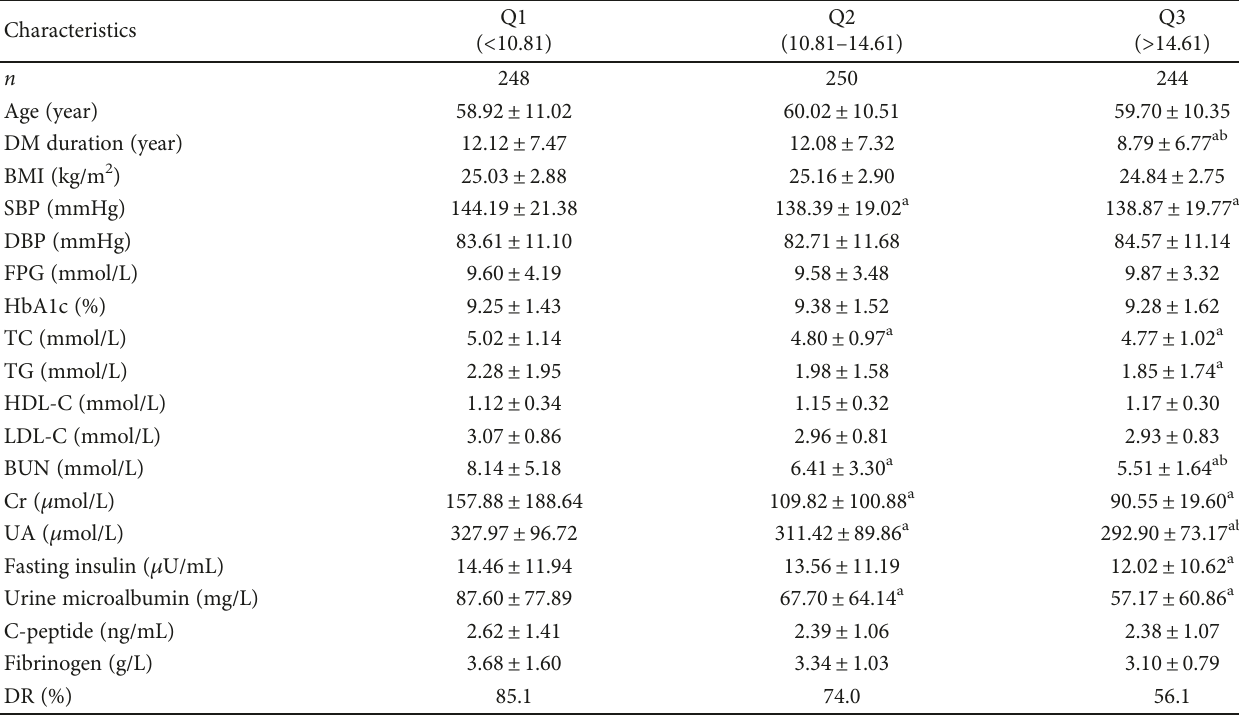
Table 3: Comparison of clinical characteristics according to STBC tertiles in total subjects.